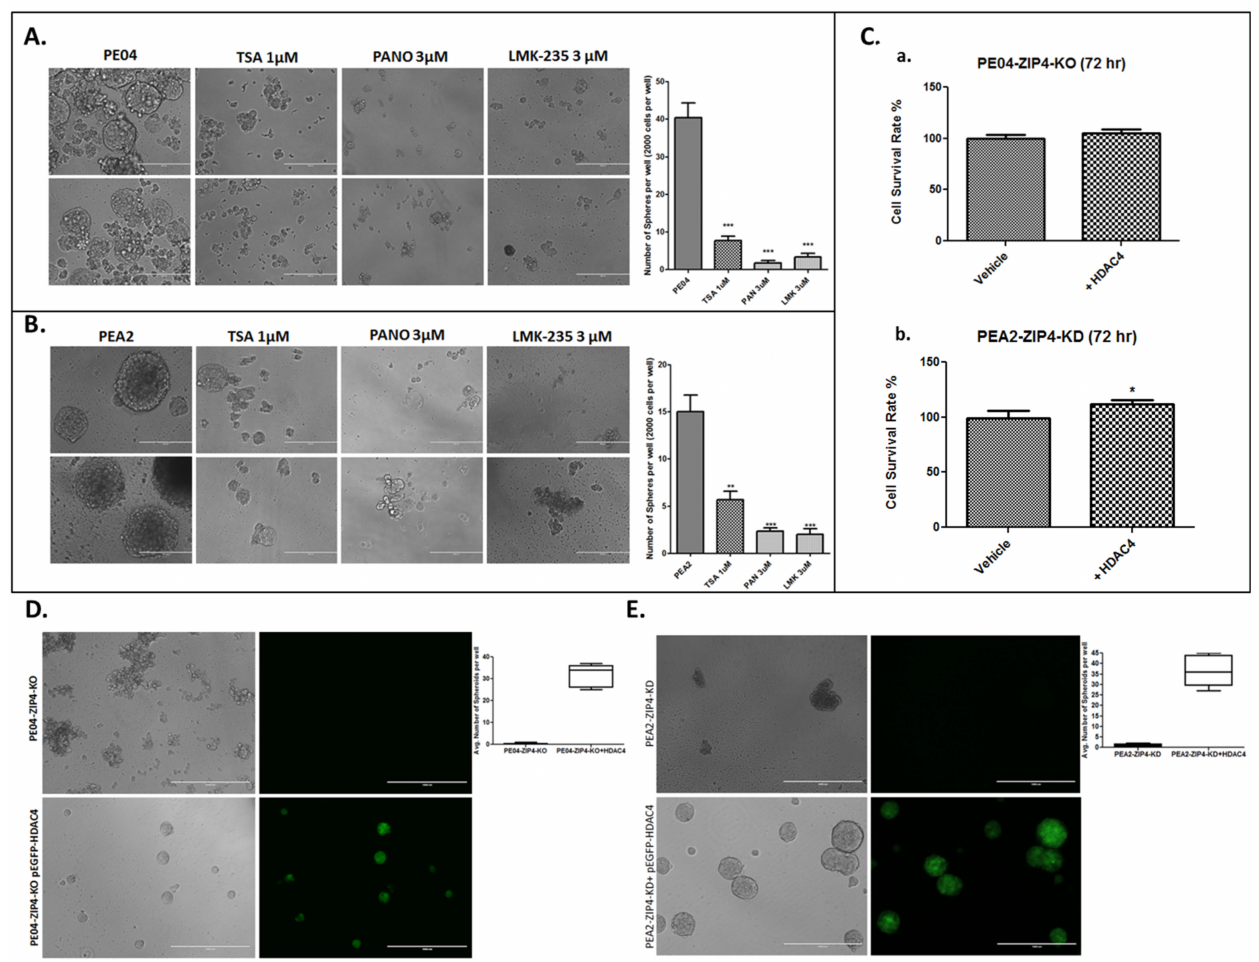
Figure 4. HDACis inhibited spheroid formation and HDAC4 gene compensated the spheroid formation activity in ZIP4- KO/KD cells. ( A , B ). HDACis (TSA, PANO, and LMK-235) inhibited spheroid formation in PE04 and PEA2 cells. The scale bars = 400 nm. Summary of quantified spheroid formation data from > three independent experiments in PE04 and PEA2 cells. ( C ) . HDAC4 gene transfected cells increased cell numbers (measured by MTT), compared to vector-transfected ZIP4-KO/KD cells. ( D , E ). HDAC4 gene transfected green cells compensated for the spheroid formation activity lost in ZIP4-KO/KD PE04 and PEA2 cells. The scale bars = 1000 nm. For quantification, cell aggregates < 70 nm and/or with irregular shapes were not counted as spheroids. Representative pictures are shown. * p < 0.05; ** p < 0.01; *** p <